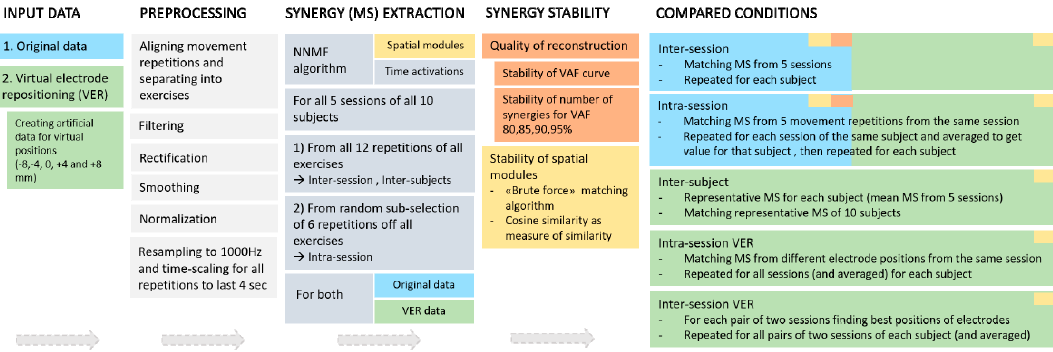
Figure 1. Overview of the steps of the data analysis that were performed. Two groups of input data were used: for the first part of the analysis, the original data from the NinaPro database (light blue background color) were used to quantify the di ff erence in variability between intra-session and inter-session conditions; for the second part of the analysis, the artificially created data (green) were used to quantify e ff ects of electrode repositioning. Preprocessing (white) was followed by synergy extraction (light gray) as described in detail in the text for both original and simulated datasets. Synergy stability was assessed using two approaches: variability in the metrics for reconstruction (variance accounted for (VAF) and number of synergies (NoS), red) and, second, assessing similarity of spatial composition of synergies